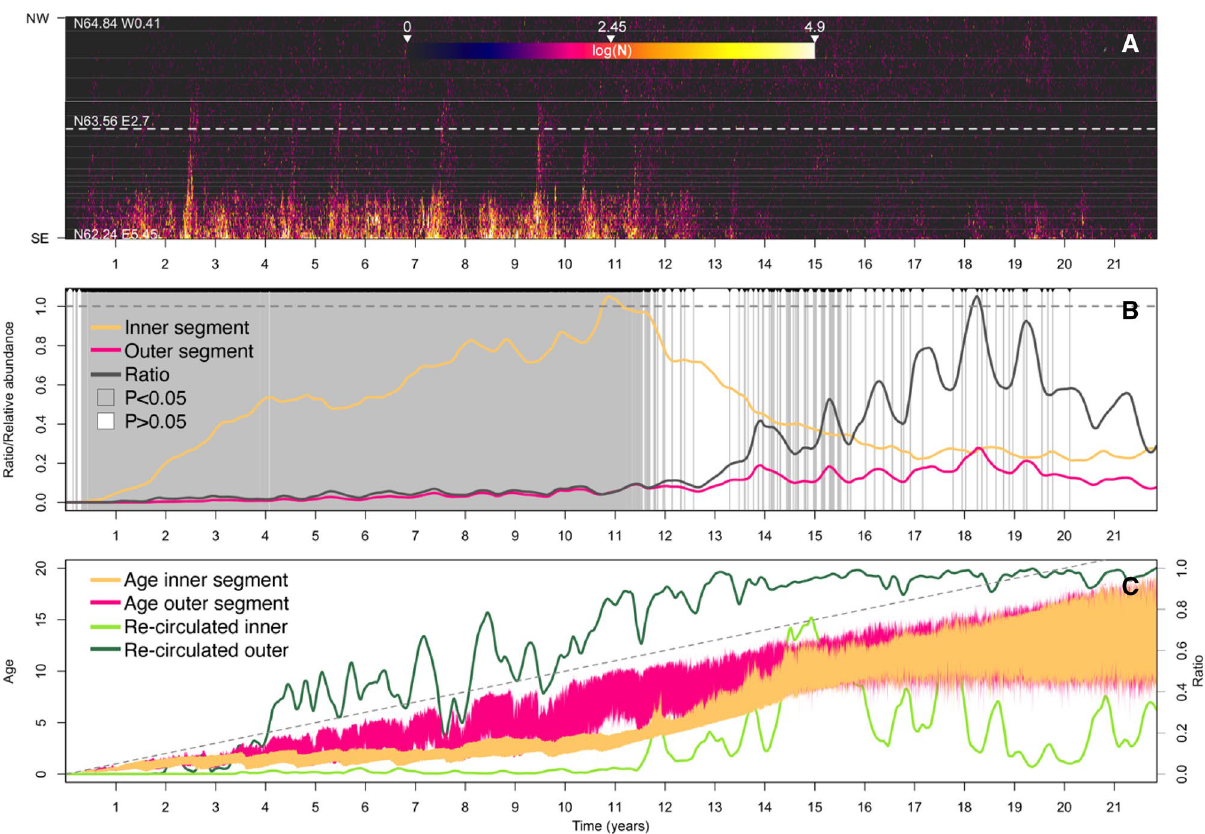
Figure 6. Temporal development of modelled flux of particles through the Svinøy transect. ( A ) Hovmöller diagram representing the modelled flux of BMP through the standard oceanographic transect “Svinøy” during the drift experiment, with thin, horizontal, white lines representing the position of the 17 fixed sampling stations. ( B ) Relative abundance of modelled particles in the inner (yellow line) and outer (pink line) segment of the transect, and ratio between the two segments (dark grey line) as divided by white perforated line in panel ( A ). Also plotted are the results from sequential nb-glmms (one for each day, grey/white vertical lines) replicating the sampling and testing scheme applied to the empirical data. ( C ) Confidence bans (1st to 3rd quartile) of modelled age of particles flowing through in inner (yellow band) and outer segment (pink band) of the Svinøy transect, and proportion of re-circulated particles (i.e. frequency of particles that already had visited the Fram Strait divided by total amount of particles drifting through the transect) in the inner section (light green line) and outer section (dark green